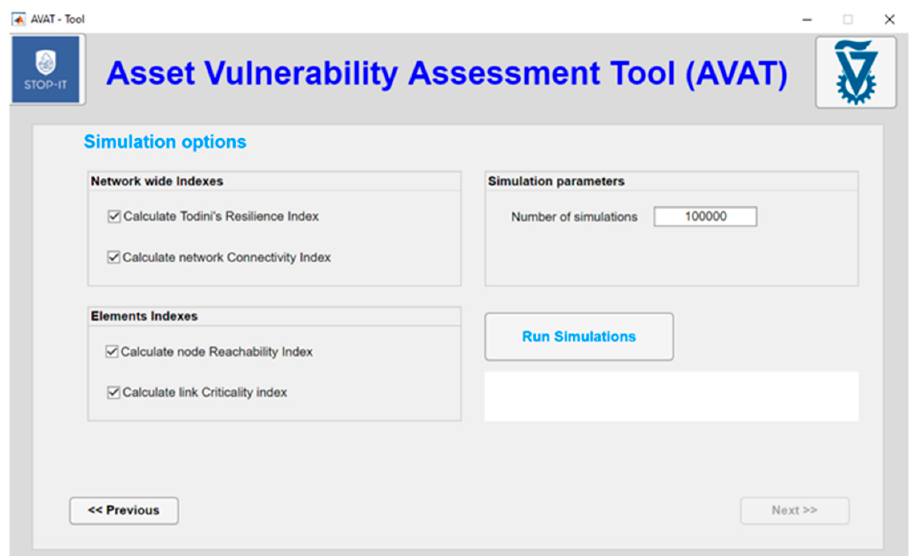
Figure 6. Simulation options window in